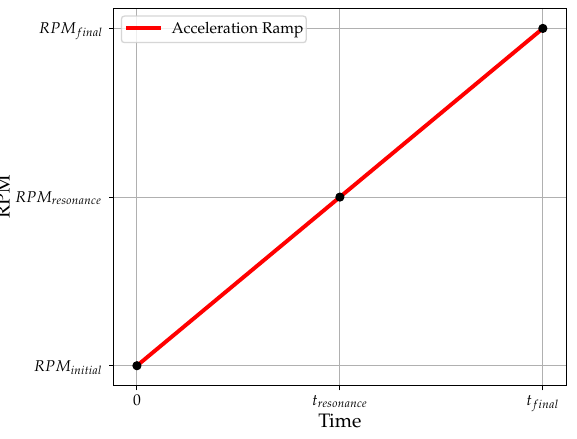
Figure 2. Acceleration ramp: the RPM initial is the starting angular velocity and RPM final is the angular velocity reached at the end of the ramp.